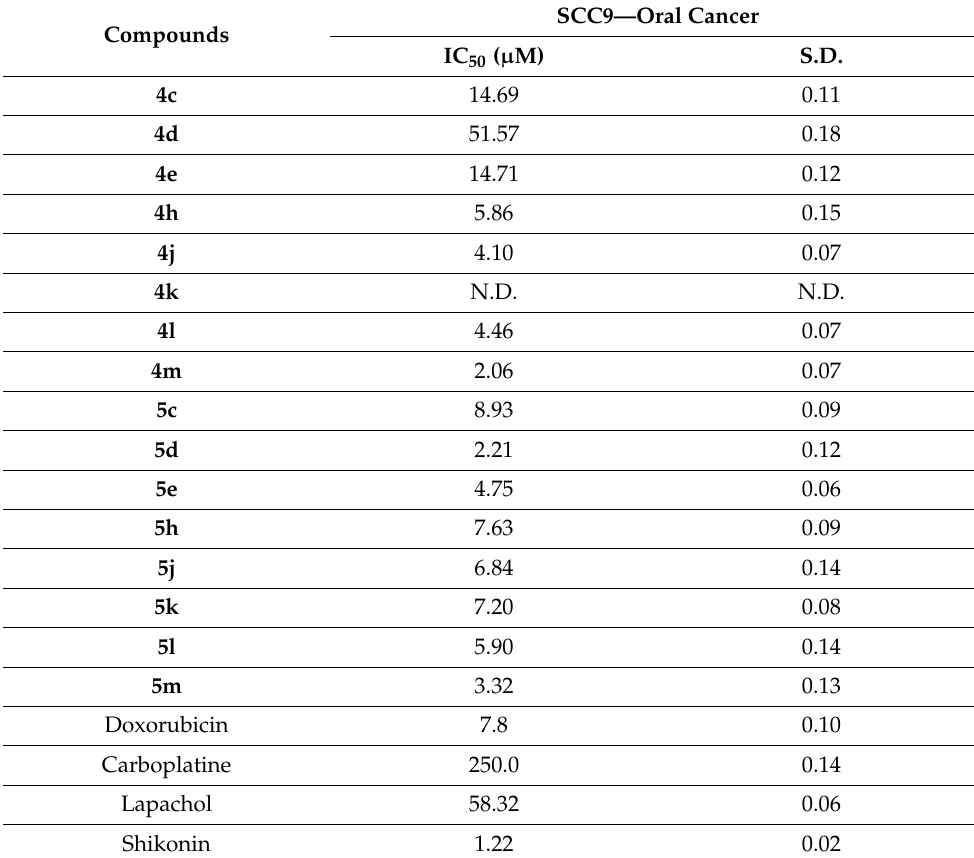
Table 1. Determination of IC 50 of acridine-core naphthoquinone compounds. SCC9 (OSCC cell) were treated with the indicated compounds for 48 h and cell viability was determined by MTT assay. Results from at least 3 independent experiments. SD = standard deviation. SCC9—Oral Cancer Compounds IC 50 ( µ M)